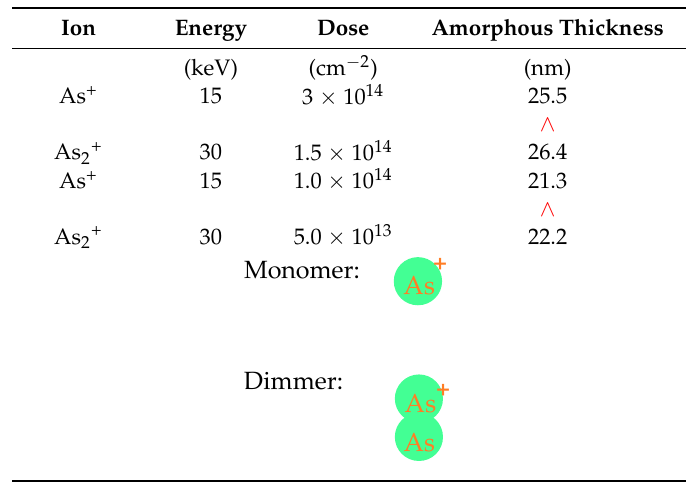
Table 1. The amorphous layer thickness by As dimer implantation, compared with that by As monomer implantation [22]. The figure illustrates As monomer and dimmer.